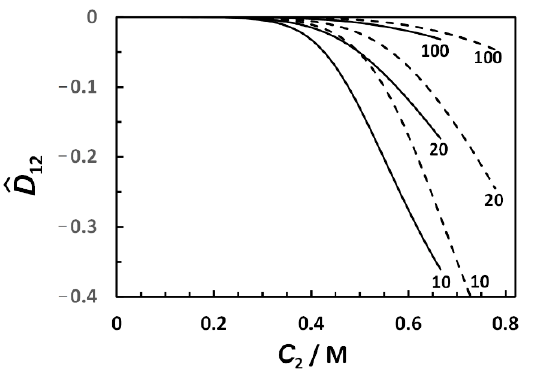
Figure 7. Reduced diffusiophoresis coefficient, ˆ D 12 , as a function of salt concentration, C 2 , calculated using Equation (13) (Na 2 SO 4 , solid curves; MgSO 4 , dashed curves). Employed values of a are appended to each curve.